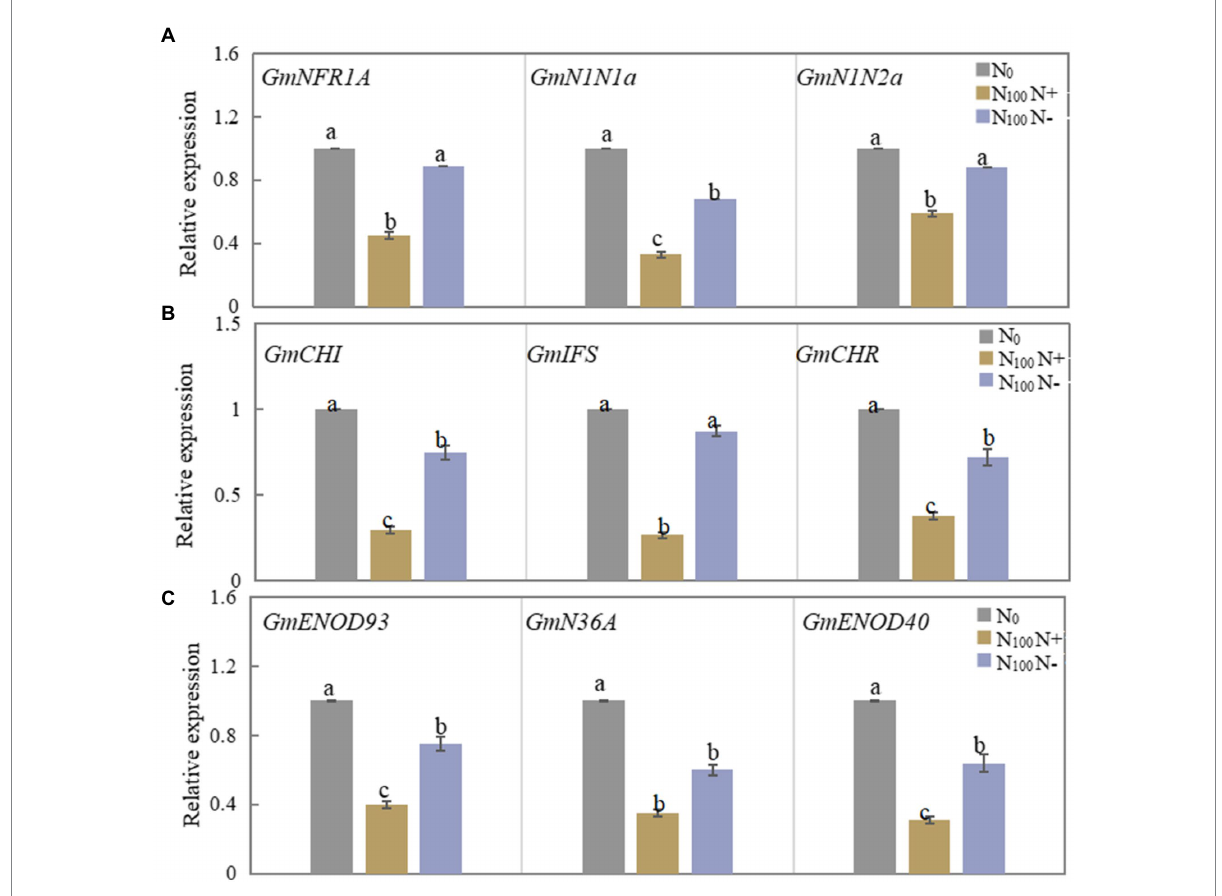
FIGURE 2 Changes of nodulation-related genes expression in roots and nodules of dual-root soybean, N 0 is N-free nutrient solution on both sides of dual- root soybeans, N 100 N+ is N-supply side of dual-root soybeans treated with 100 mg/l nutrient solution on unilateral side, N 100 N-is N-free side of dual-root soybeans treated with 100 mg/l nutrient solution on unilateral side, different lowercase letters above the bars indicate significant difference ( p < 0.05) by Duncan’s multiple range test. (A) The expression level of the nodulation signal recognition gene on both sides of dual-root soybean after treatment for 3 days. (B) The level of expression of the genes for roots isoflavone synthesis on both sides of the dual-root soybean after 7 days of treatment. (C) The level of expression of the genes of early nodulin synthesis in root nodules after 21 days of